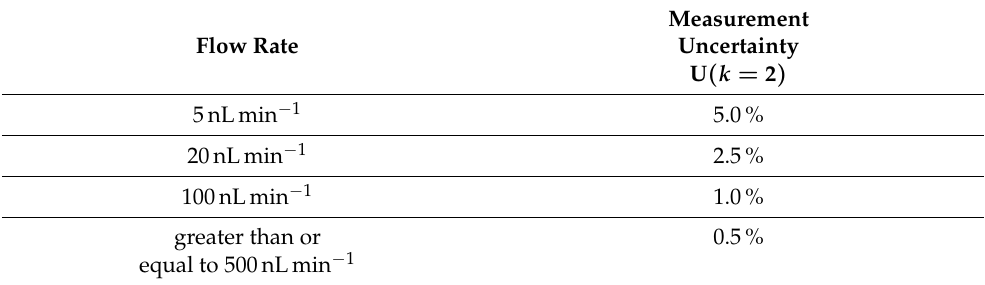
Table 2. Expanded measurement uncertainty U ( k = 2 ) of the Nanoflow test facility at different flow